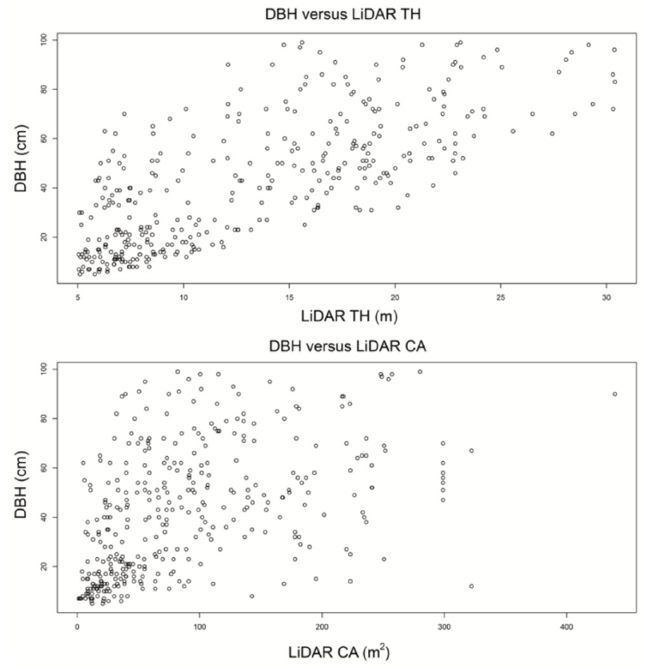
Figure A1. The relationship between LiDAR TH/LiDAR CA and DBH.